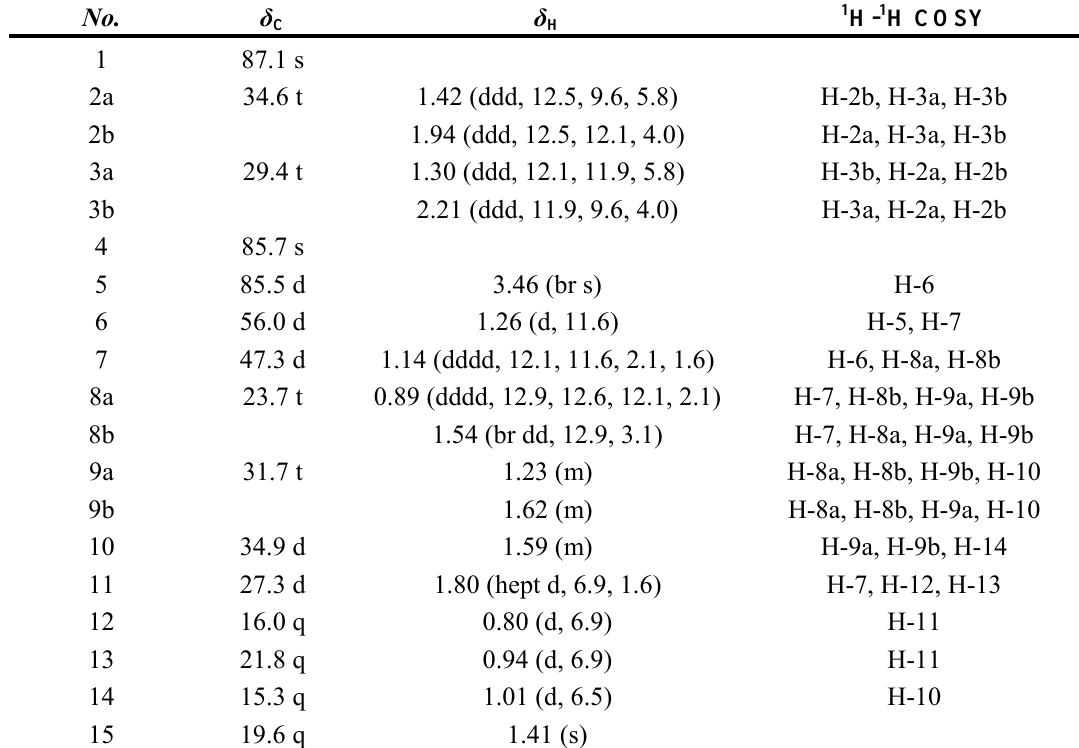
Table 1. 1 H and 13 C-NMR data and 1 H- 1 H COSY correlations of compound 1 (in CDCl in ppm, J in